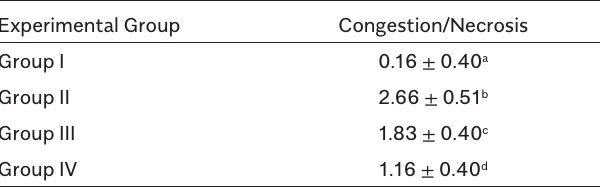
Table 3. Comparison of Histopathological Findings for All Groups Experimental Group